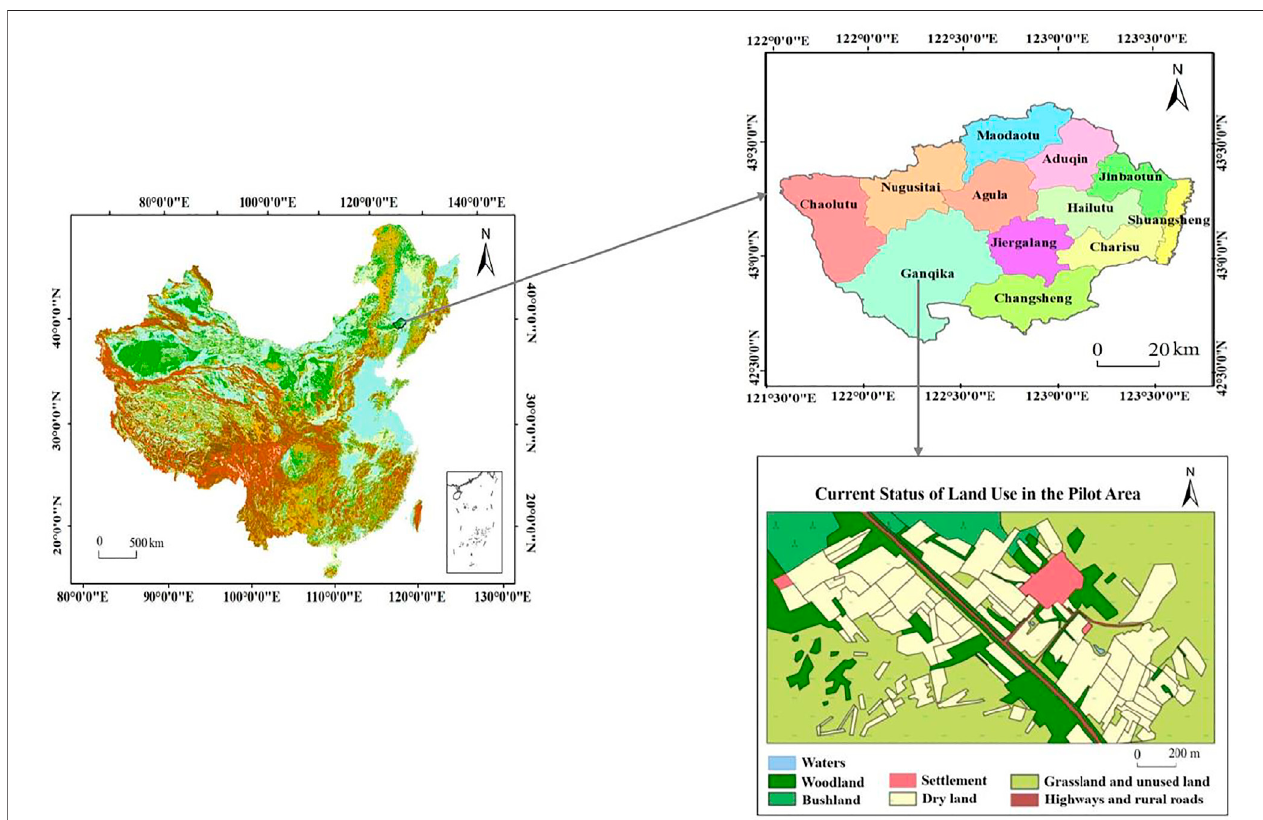
FIGURE 1 | Study area